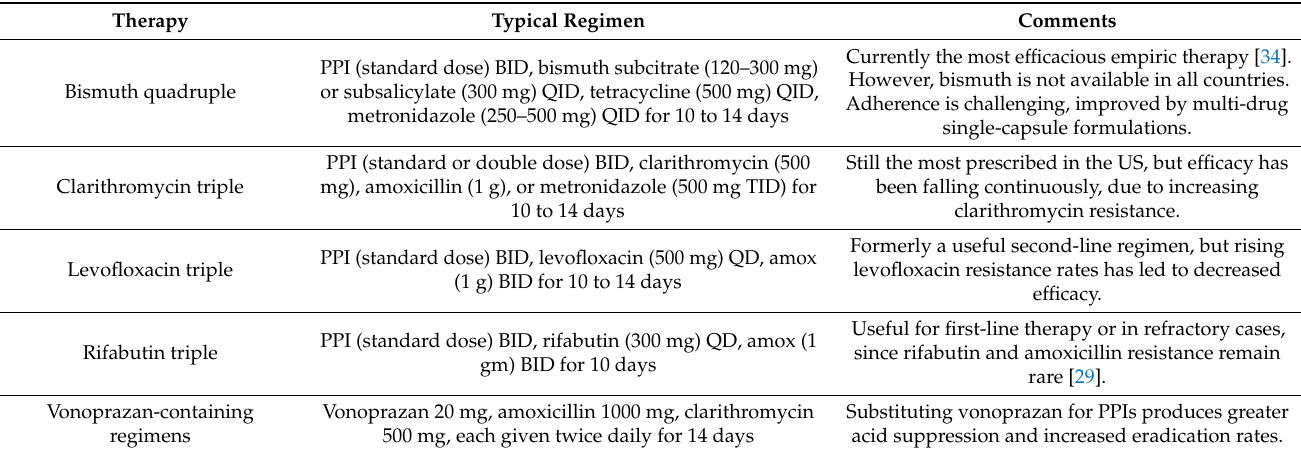
Table 1. Some common therapies used for H. pylori eradication.